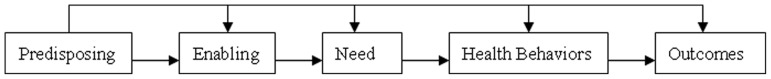
Andersen's behavioral model.